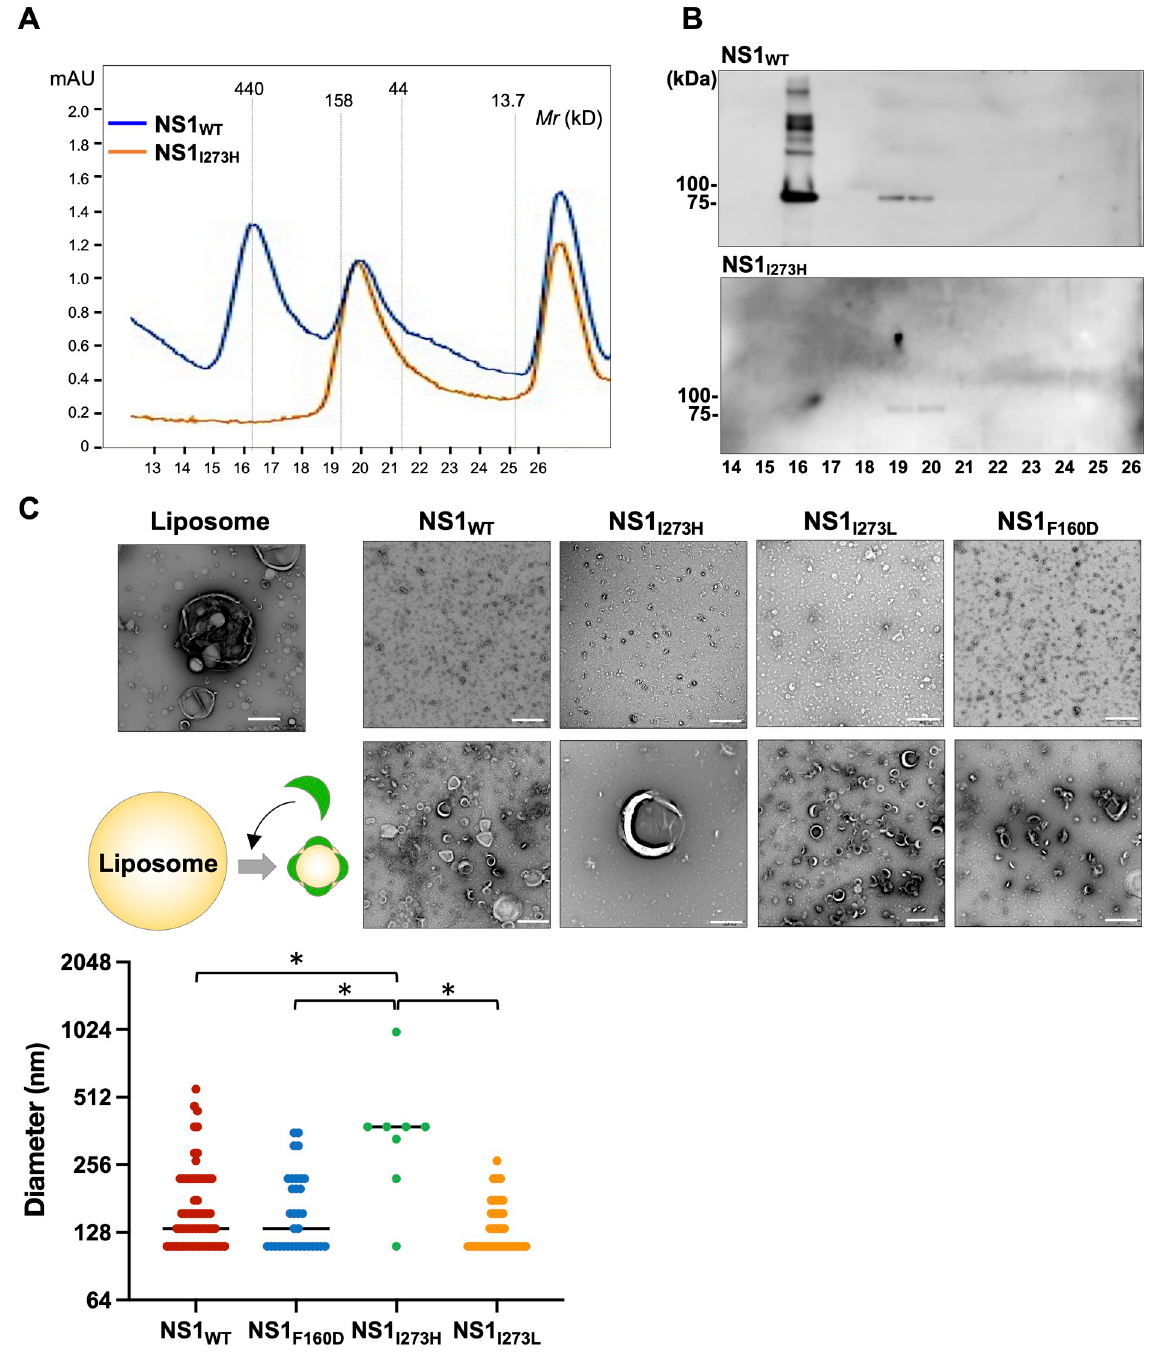
Fig 5. Higher oligomerization of NS1 is responsible for the membrane association and secretion into the culture supernatants. (A) The properties of the wild type NS1 and mutant NS1 I273H carrying MBP-tag were analyzed by fast protein liquid chromatography (FPLC). (B) The expressions of the wild type NS1 and mutant NS1 I273H in each fraction were confirmed by immunoblotting using anti-NS1 antibody. (C) An illustration shows the image of liposome alteration by incubation with NS1. Conversion of liposomes into small heterogeneous lipid particles was examined by the incubation with NS1. The purified wild type NS1 or mutant NS1 (I273H, I273L and F160D) was incubated with the liposomes (composition 1:9 cholesterol:phosphatidylcholine) and visualized by the negative-stain EM. White scale bars represent 500 nm. The dot graph showed the size of liposome incubated with the respective NS1 proteins. Statistical significances were determined by the Kruskal– Wallis test with pairwise comparisons using Tukey-Kramer-Nemenyi all-pairs test with Tukey-Dist approximation. Significantly different values are indicated by asterisks ( �